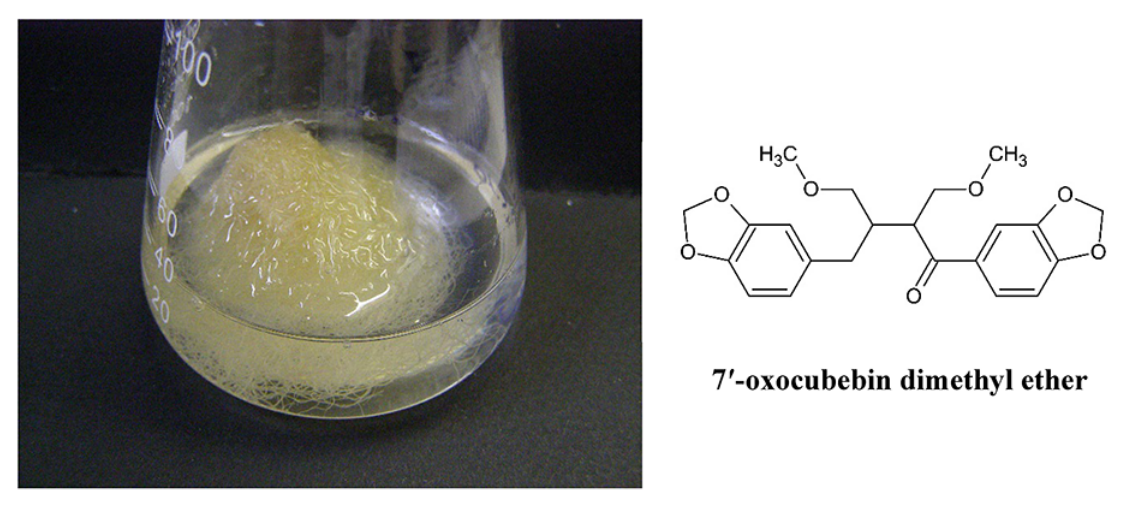
Figure 16 Non-transformed root culture of Phyllantus amarus